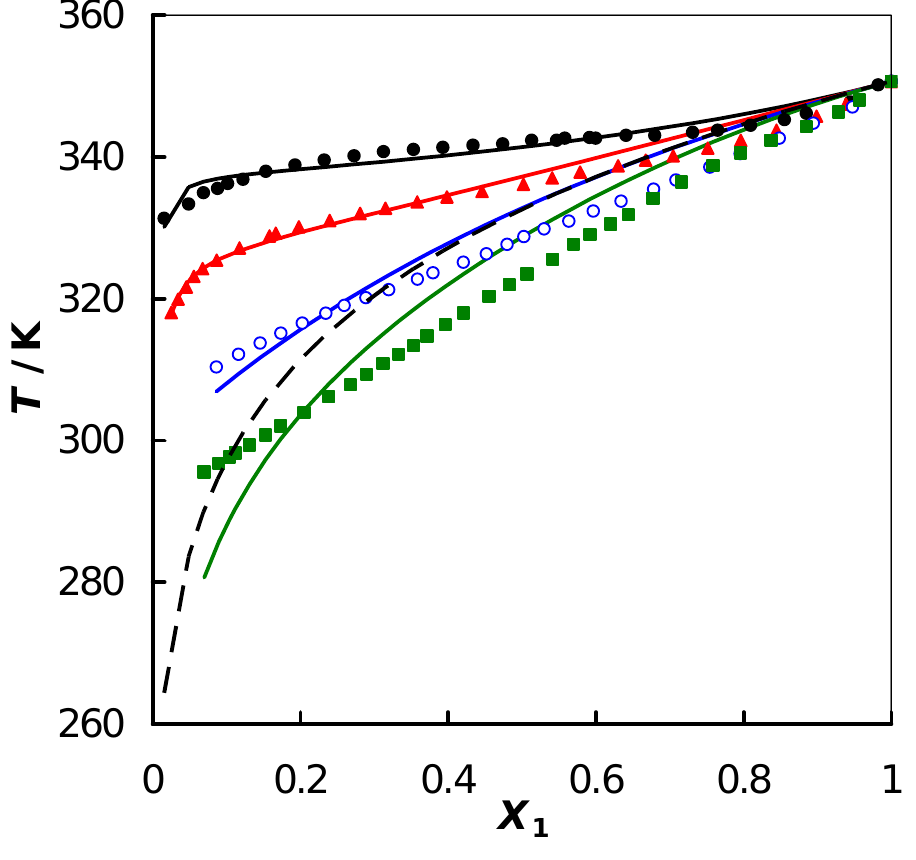
SO ] + an alcohol}: 3 3